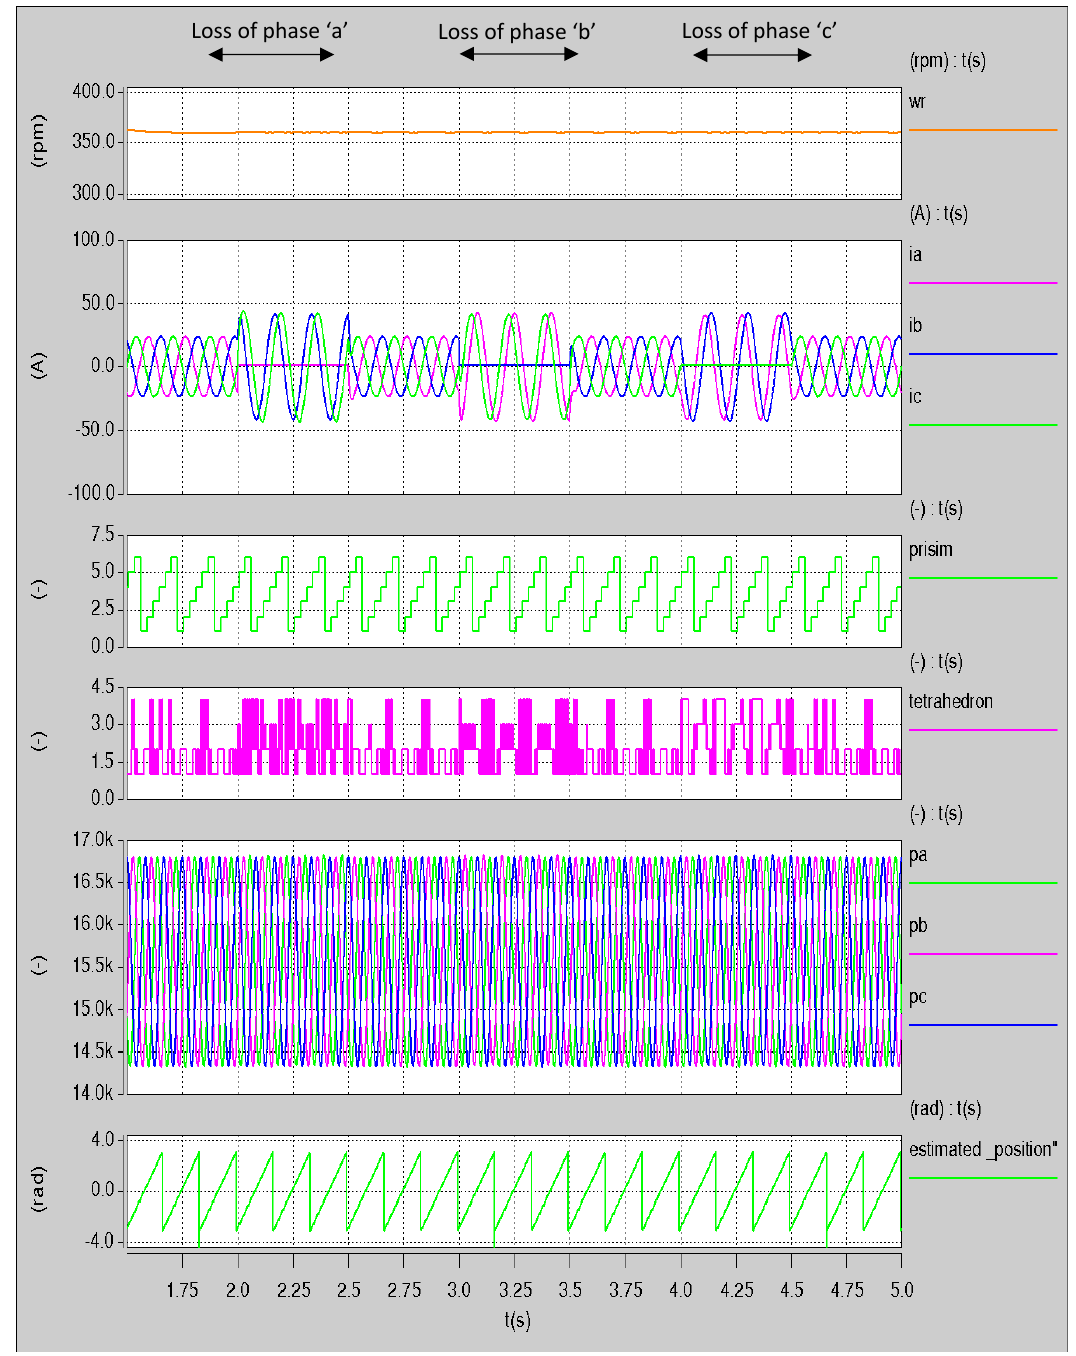
Figure 10. Tracking the saliency in a 4-leg inverter using 3D-SVPWM under normal operating condition and post a loss of one phase.